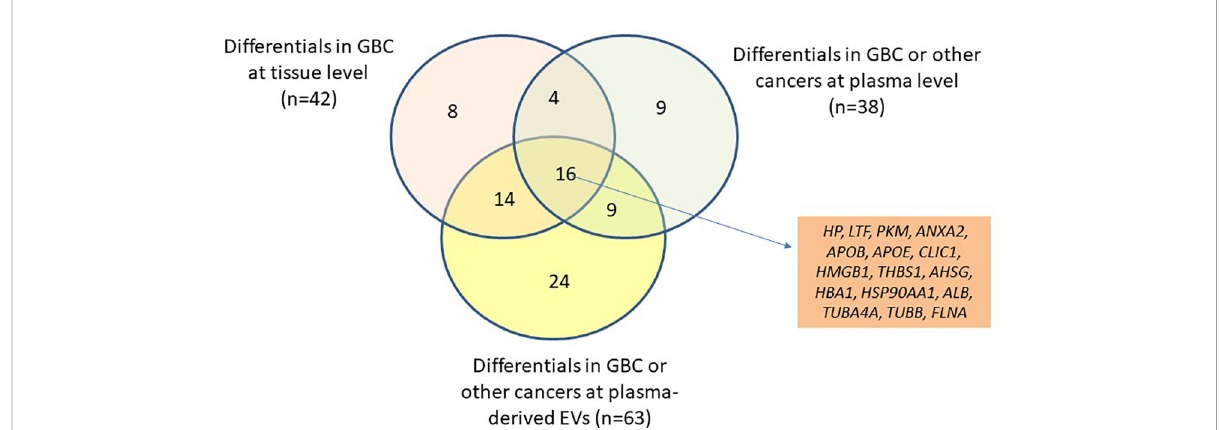
FIGURE 4 Venn diagram showing the differential level of 110 proteins in tissue (GBC) and in plasma/serum or plasma/serum-derived EVs (GBC or other cancers). The differential level of 16 proteins were already reported in tissue, plasma/serum and plasma/serum-derived EVs and are candidate proteins to be explored as circulatory markers for GBC. HP, Haptoglobin; LTF, lactotransferrin isoform 1; PKM, pyruvate kinase isoform X1; ANXA2, annexin A2; APOB, apolipoprotein B-100; APOE, apolipoprotein E isoform a; CLIC1, chloride intracellular channel protein 1; HMGB1, high mobility group protein B1 isoform X1; THBS1, thrombospondin-1; AHSG, alpha-2-HS-glycoprotein isoform 2; HBA1, hemoglobin subunit alpha; HSP90AA1, heat shock protein HSP 90-alpha isoform 1; ALB, serum albumin; TUBA4A, tubulin alpha-4A chain isoform 1; TUBB, tubulin beta chain isoform b; FLNA, Filamin-A isoform 2 .